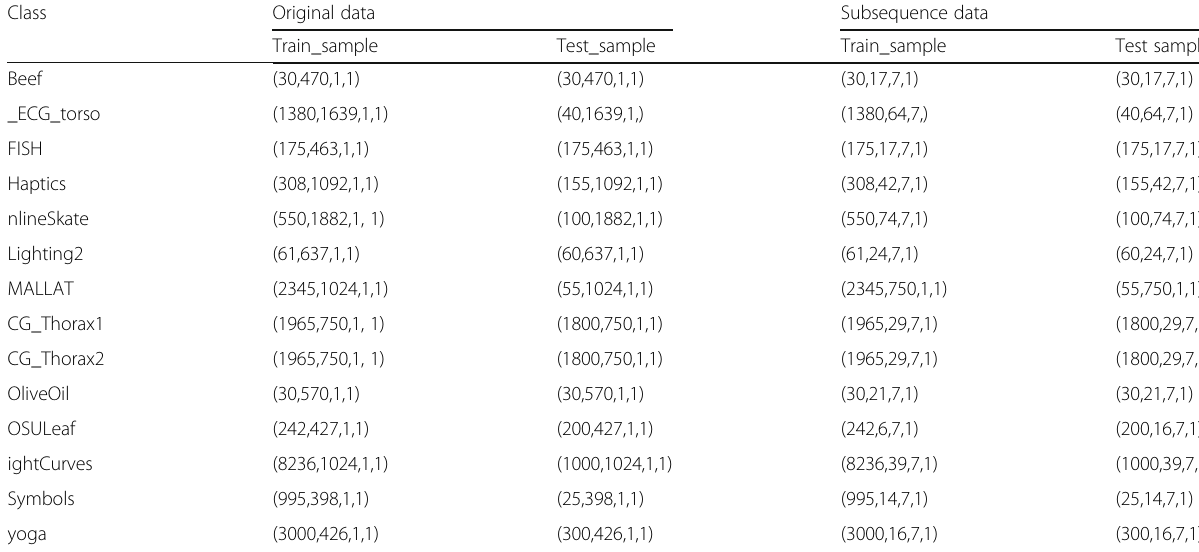
Table 1 The dimensions of OTS and new